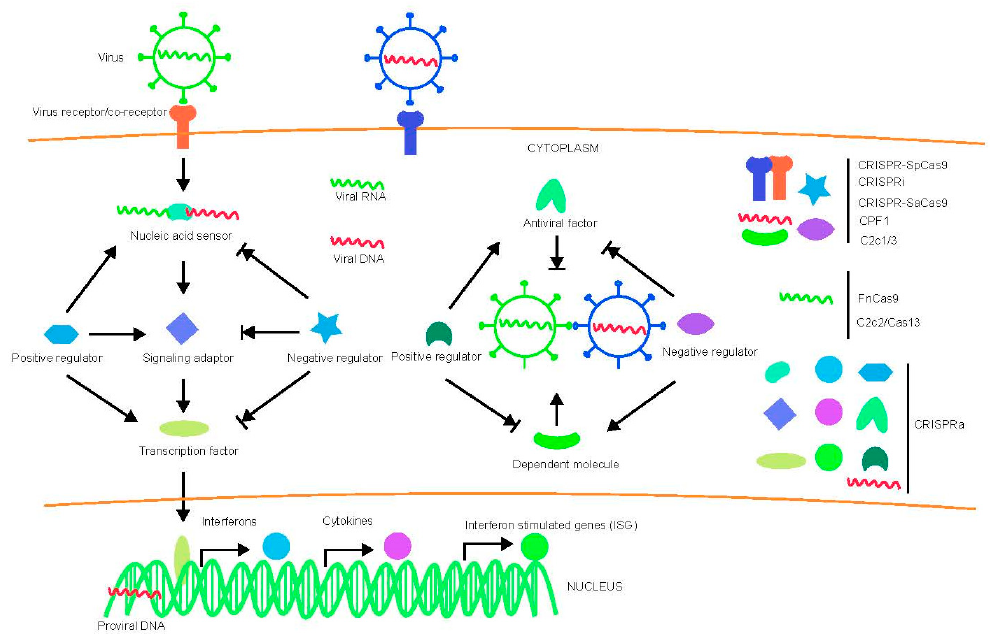
Figure 1. Diagram of virus-host interactions and possible targets for various CRISPR-Cas system. Arrow indicates promotion and arrow with short vertical line indicates inhibition.